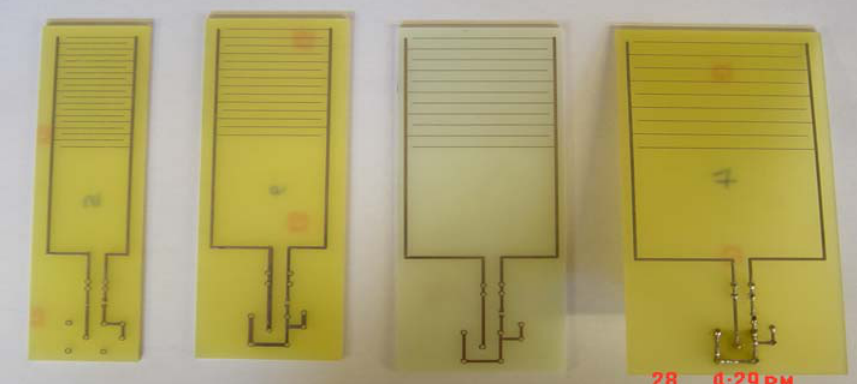
Figure 9. Fabricated interdigital type